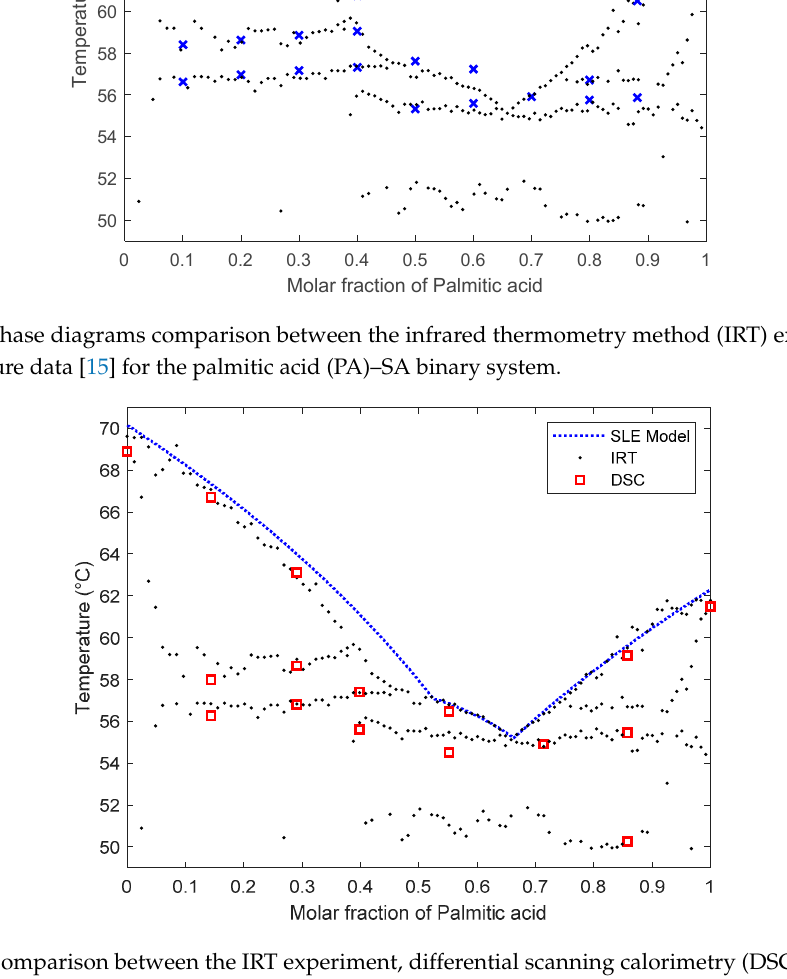
Figure 5. Comparison between the IRT experiment, differential scanning calorimetry (DSC) analysis and the numerical approach for the (PA–SA) binary system.